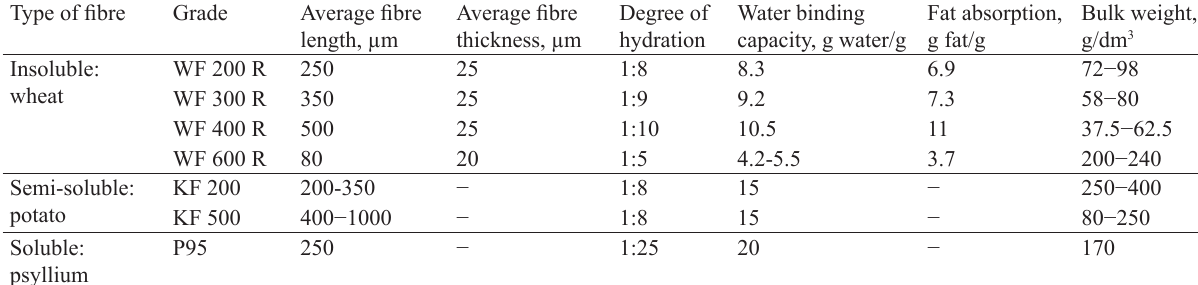
Table 1 Technological properties of SuperCel fibres Type of fibre